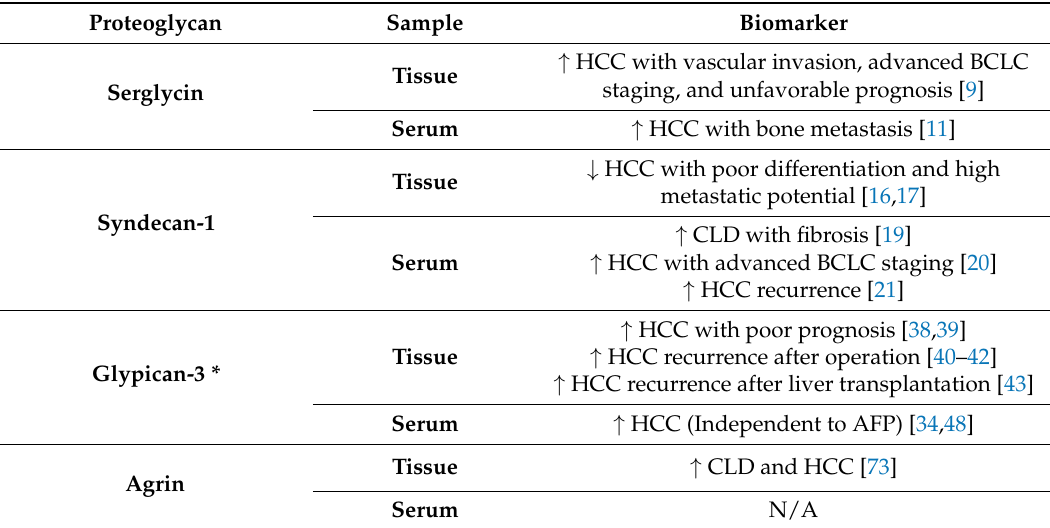
Table 2. Proteoglycans as biomarkers in liver